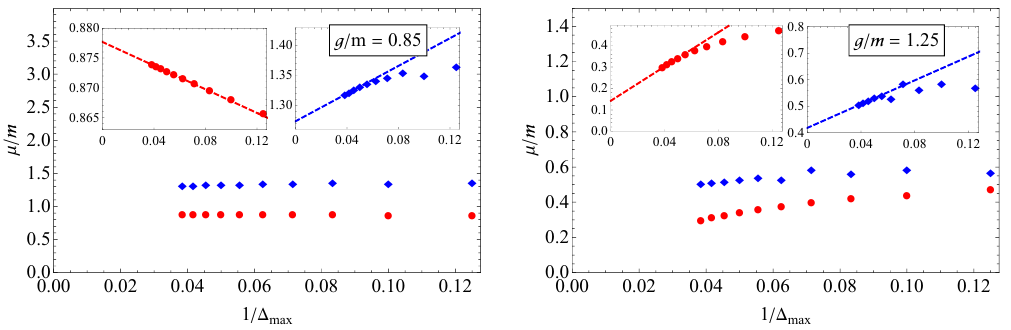
Figure 16 . The convergence of the first (red circle) and second (blue diamond) lowest mass eigenvalues at strong couplings g = 0 . 85 (left plot) and g = 1 . 25 (right plot). The plot shows the eigenvalues at fixed g as a function of 1 / ∆ max . The insets of the plots zoom in to each individual eigenvalue to show the dependence on 1 / ∆ max . The dashed trend lines are linear fits of the last 4 points. At the smaller coupling, g = 0 . 85, both eigenvalues have converged well. At the larger coupling, g = 1 . 25, which is close to the TIM critical point, both eigenvalues are still changing as a function of ∆ max . The lowest eigenvalue at g = 0 . 85 has a clear linear dependence on 1 / ∆ max . The others have slower convergence rates. The changing slope may suggest that the dependence on 1 / ∆ max has a different power, or the dependence is linear but the slopes have not converged to